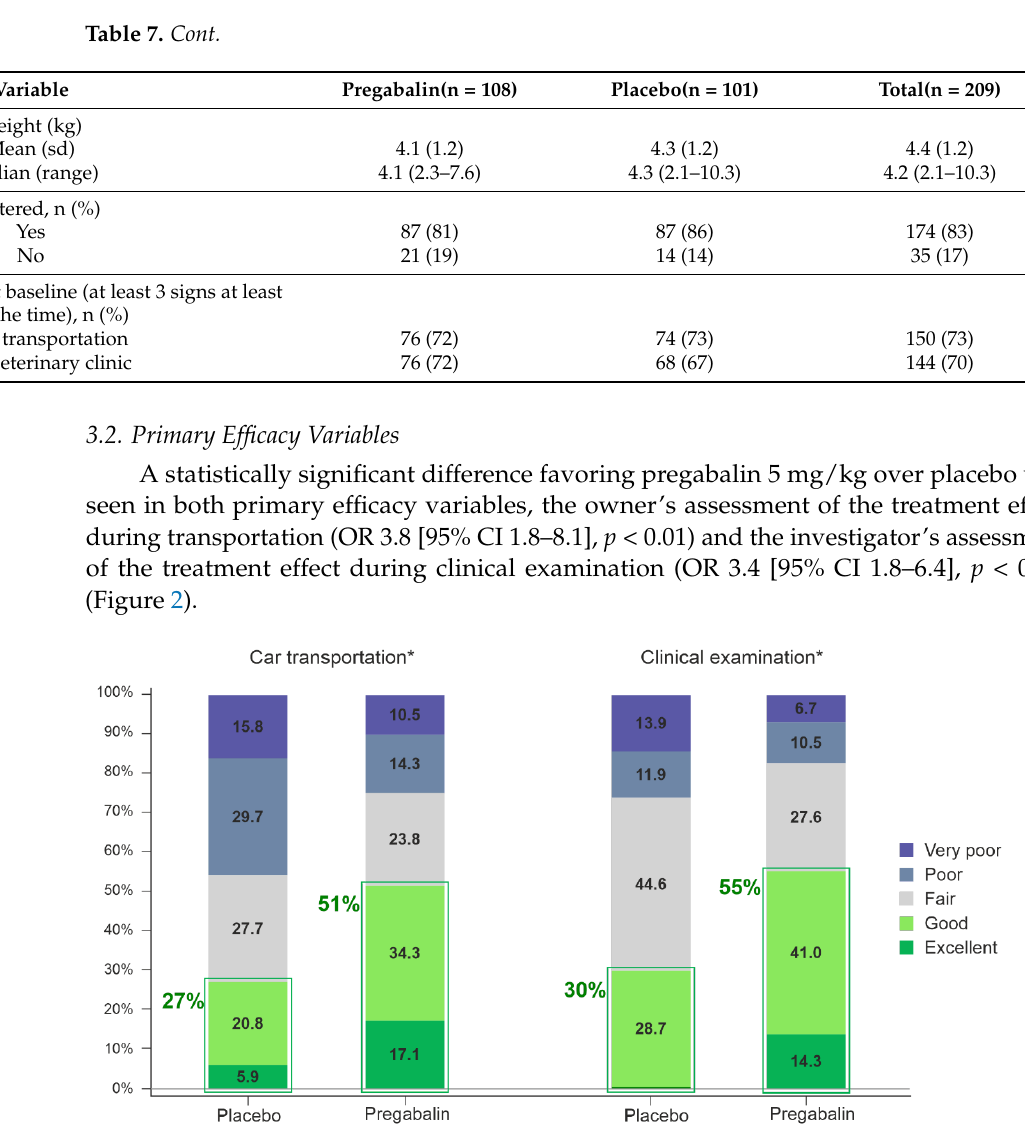
Figure 2. Distribution of responses (percentage of cats) for owner’s assessment of the treatment effect during transportation and investigator’s assessment of the treatment effect during clinical examination. * Indicates a statistically significant difference between pregabalin 5 mg/kg and placebo treatments.